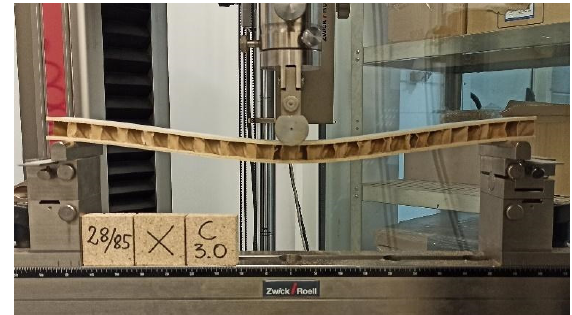
Figure 4. Test stand.